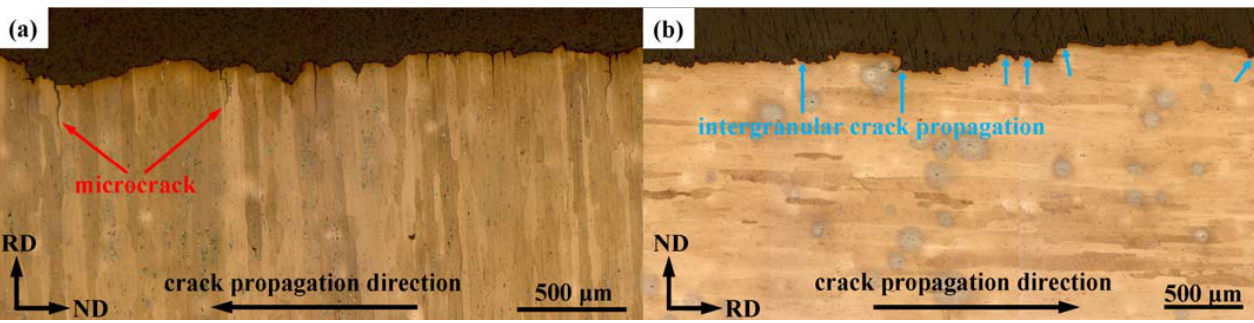
Figure 10. Optical images of fatigue crack at steady state stage in CT specimen: ( a ) RD specimen; ( b ) ND specimen.